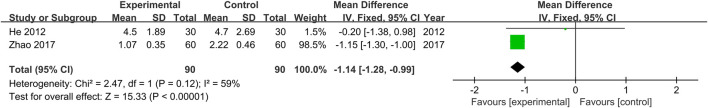
Forest plot for the meta-analysis of Mayo (endoscopy) scores.